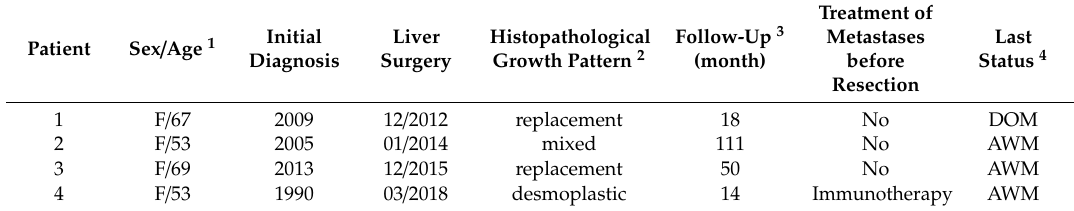
Table 1. Metastatic uveal melanoma patients’ survival